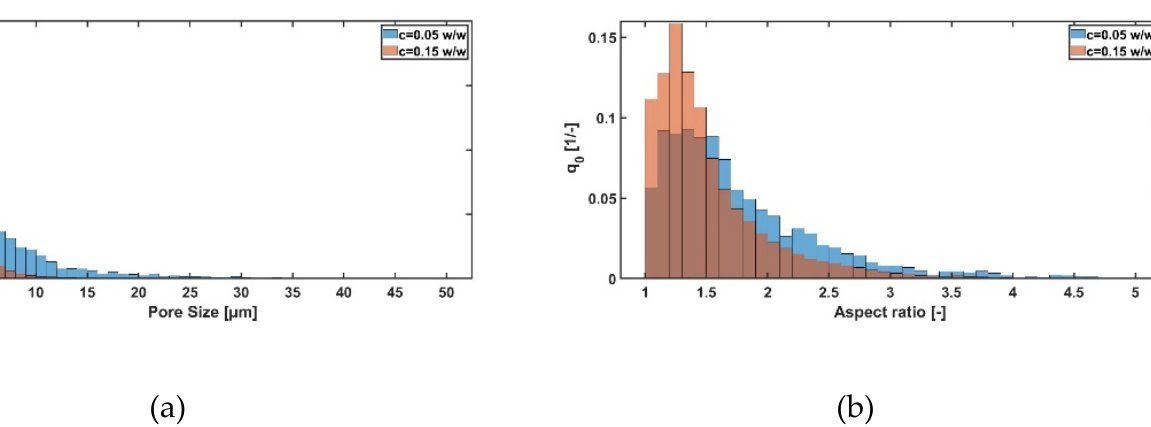
Figure 5. Influence of sugar type (c = 0.05 w/w; 1 K/min cooling rate) on ( a ) the pore size distribution and ( b ) aspect ratio.